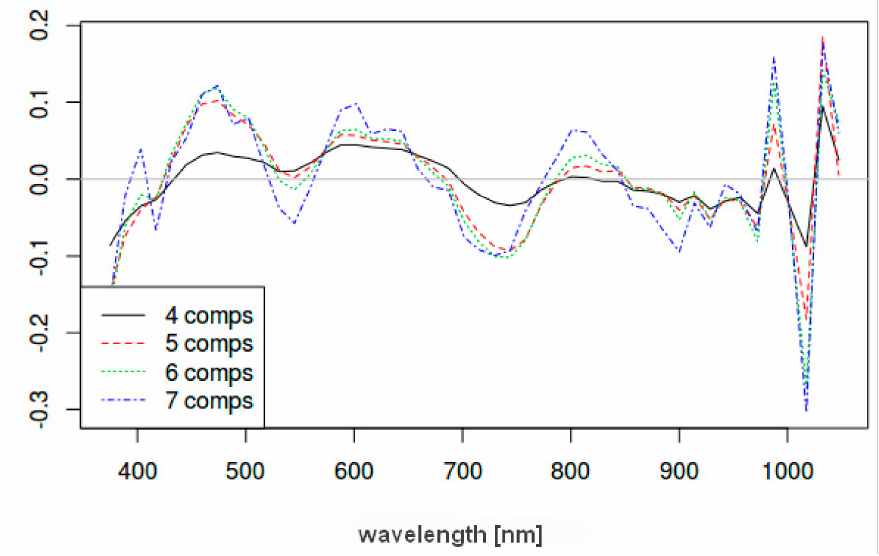
Figure 7. Regression coefficients for four to seven components. The y-axis shows the values of the regression